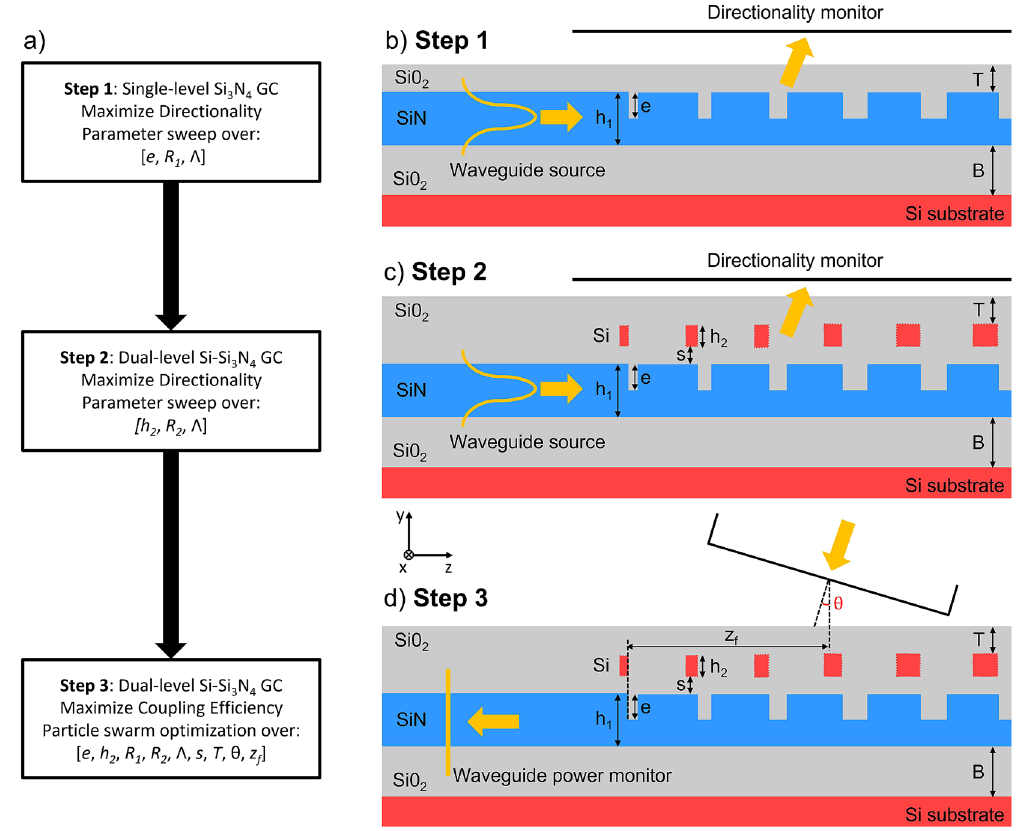
Figure 2. ( a ) Schematic of the optimization strategy followed in the design of the dual-level Si–Si 3 N 4 GC; cross-sectional schematic and simulation layout used to maximize the directionality in ( b ) step 1 and ( c ) step 2 and the CE in ( d ) step 3 of the design